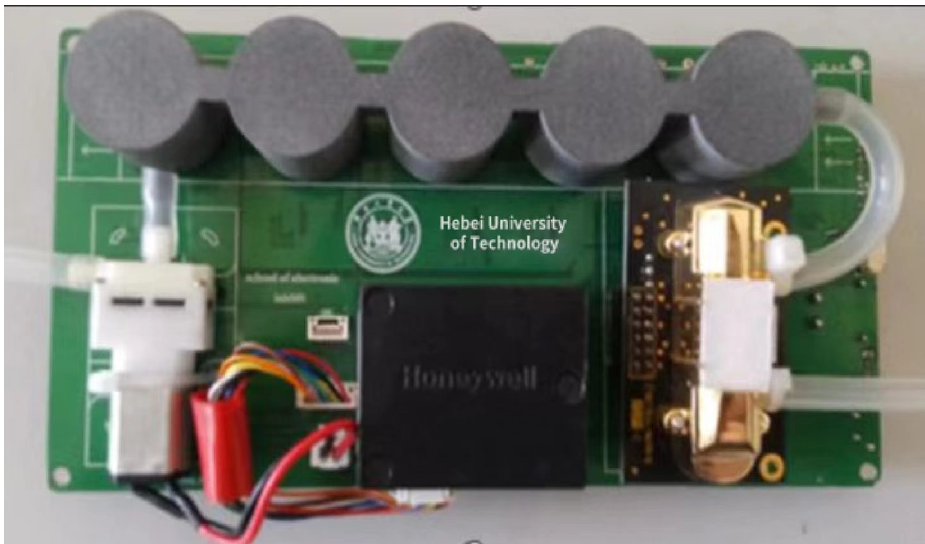
Figure 9. PCB physical picture of monitoring terminal.